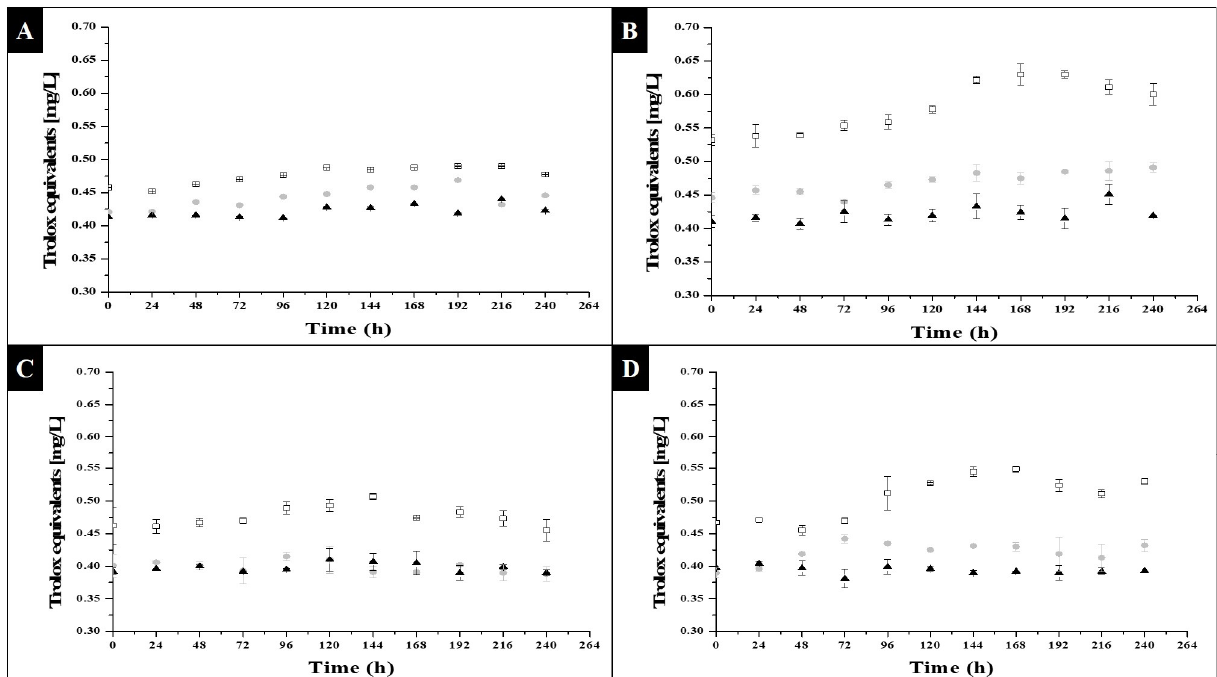
Figure 5. Antioxidant activity of C. vulgaris under photoheterotrophic growth with DPPH • method: ( A ) sodium acetate in 8 light hours and 16 darkness photoperiods; ( B ) sodium acetate in 16 light hours and 8 darkness photoperiods. (cid:3) 0.0005 g/L, • 0.001 g/L and (cid:78) 0.0015 g/L sodium acetate concentration; ( C ) glycerol in 8 light hours and 16 darkness photoperiods; ( D ) glycerol in 16 light hours and 8 darkness photoperiods. (cid:3) 0.27 g/L, • 0.33 g/L and (cid:78) 0.44 g/L glycerol